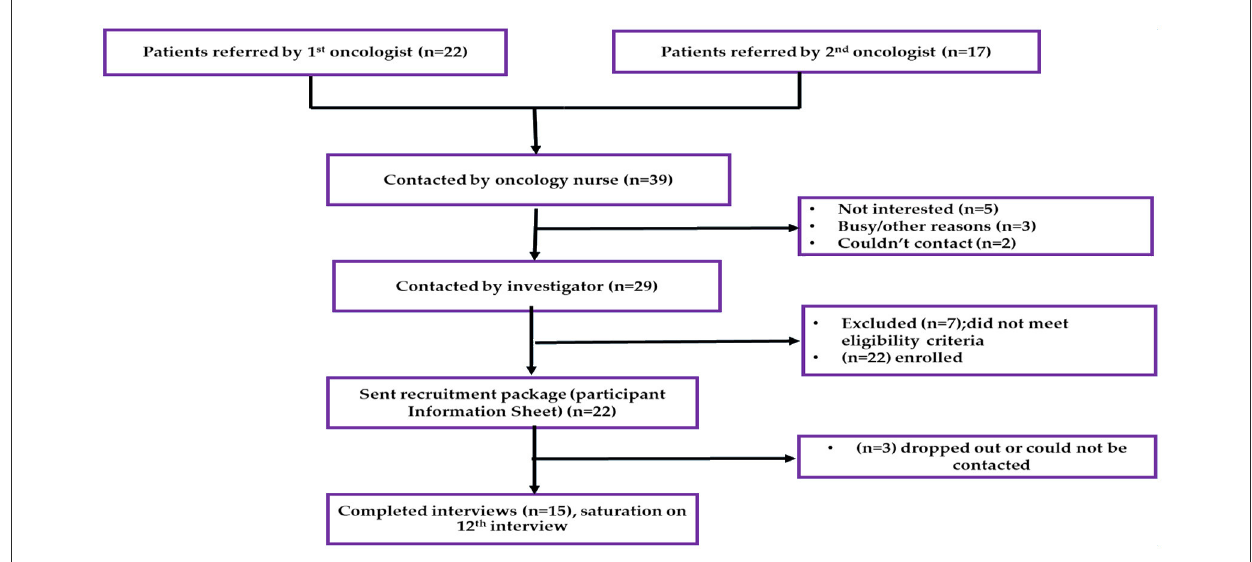
FIGURE1 Study flow